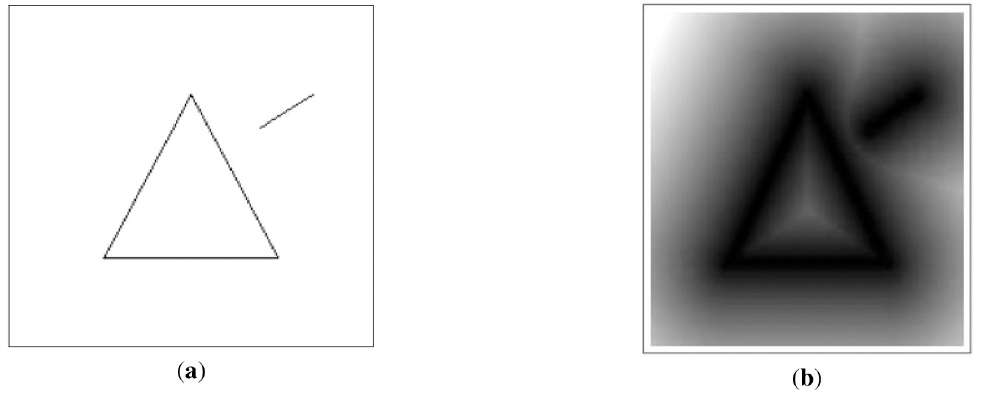
Fig 1. ( a ) One-hot mask; ( b ) Distance transform